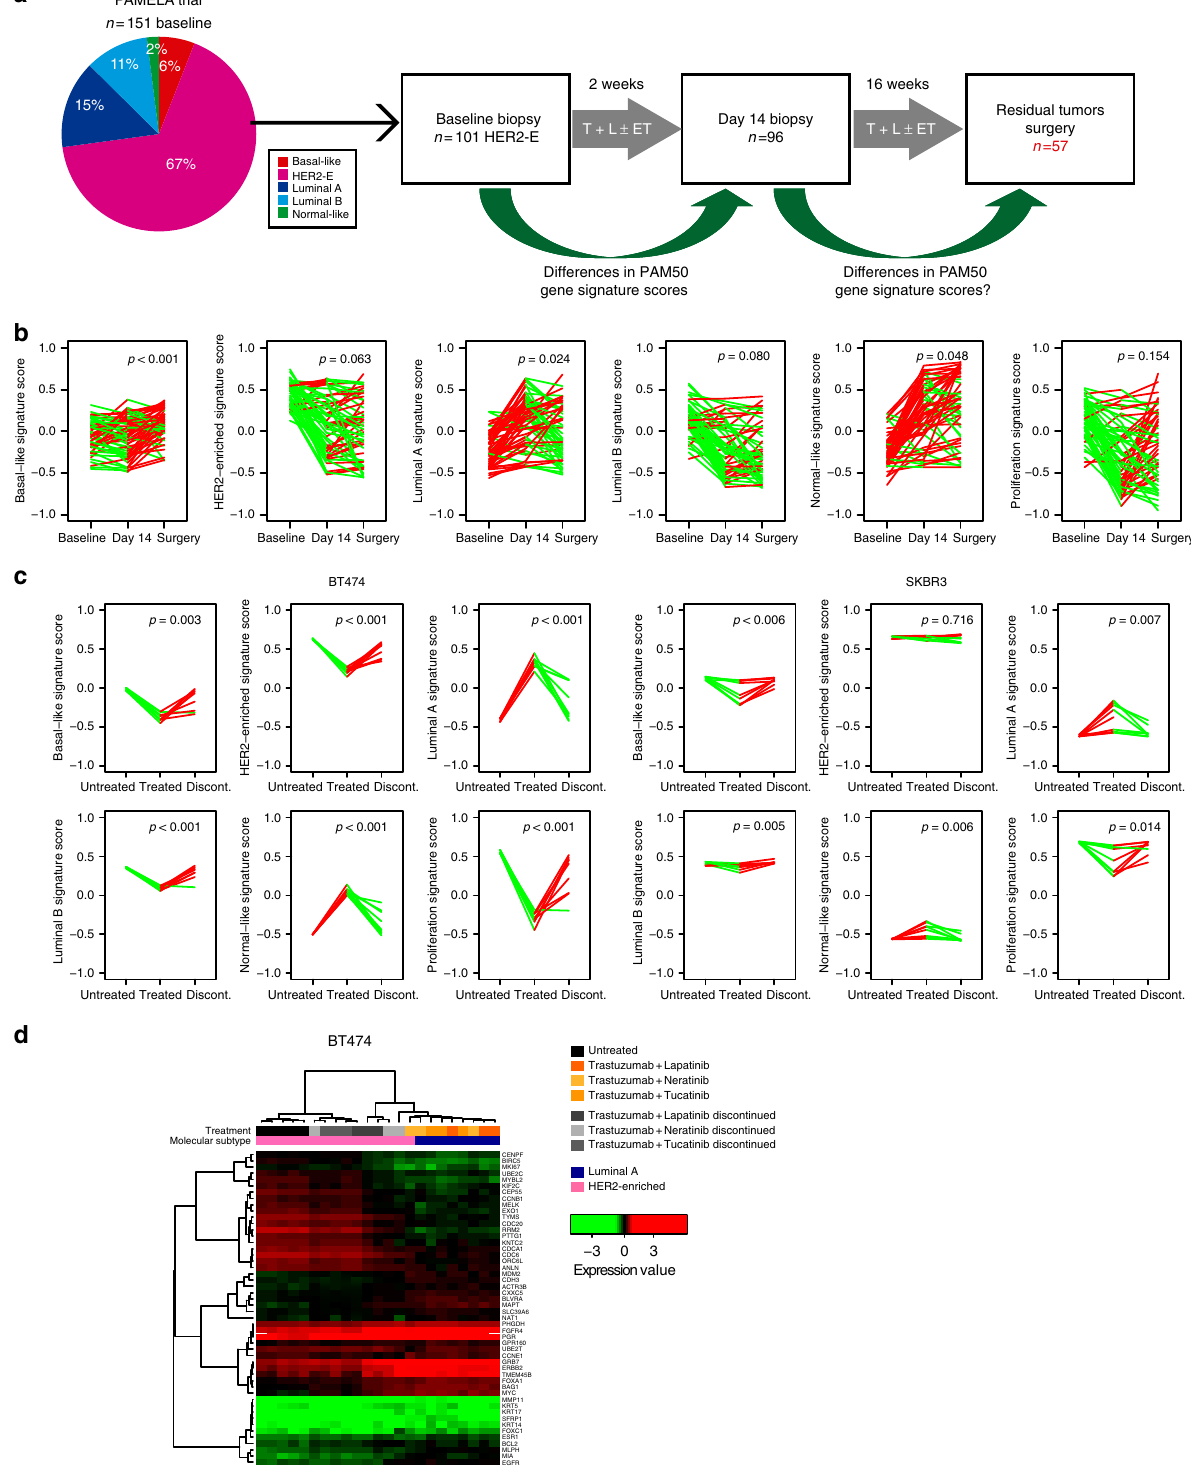
Fig. 3 Biological changes after dual HER2 blockade. a Schematic representation of the work fl ow to identify differences in PAM50 gene expression signatures in HER2-E tumors at baseline of the PAMELA trial between day 14 of treatment and residual tumors. b PAM50 signature expression changes between baseline, day 14 and surgery in 57 residual tumors at surgery. Each line represents a tumor sample. Increases are represented in red and decreases in green. P -values ( p ) were determined by two-tailed paired t -tests. c PAM50 signature scores in BT474 and SKBR3 cells untreated, treated with TKI + trastuzumab for 72 h and upon treatment discontinuation for 72 h. Each line represents a paired sample. P -values ( p ) were determined by two-tailed paired t -tests. d Unsupervised hierarchical clustering using the PAM50 genes across untreated BT474 cells, treated cells with combinations of TKI and trastuzumab for 72 h and cells where treatment was removed for another 72 h. The heatmap shows high (red) to low (green) expression of mRNAs in each sample. The molecular subtype call of each sample is